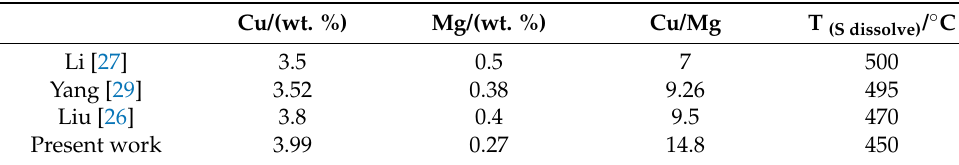
Table 3. Effect of Cu/Mg ratio on the dissolution temperature of S phase. Cu/(wt. %)